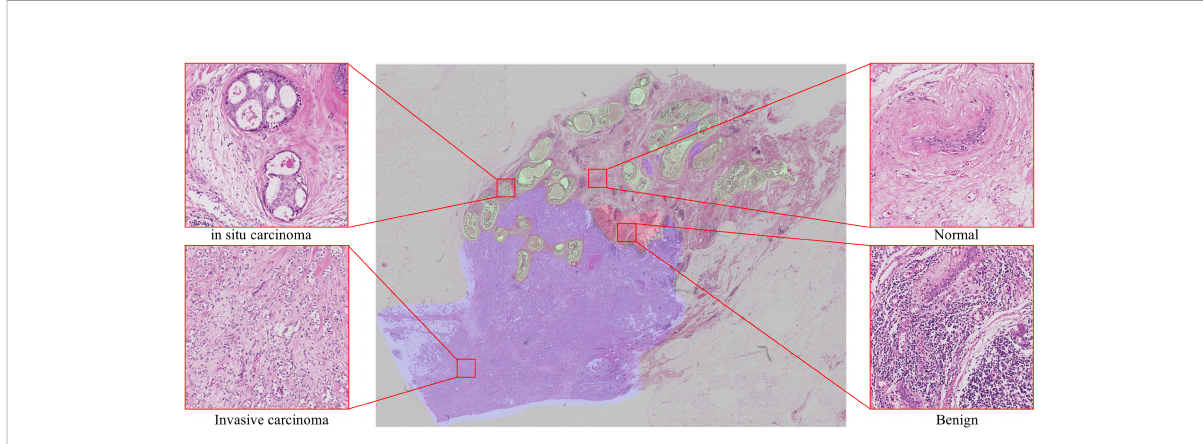
FIGURE 1 Examples show four classes in breast histology microscopic images: normal, benign, in situ carcinoma and invasive